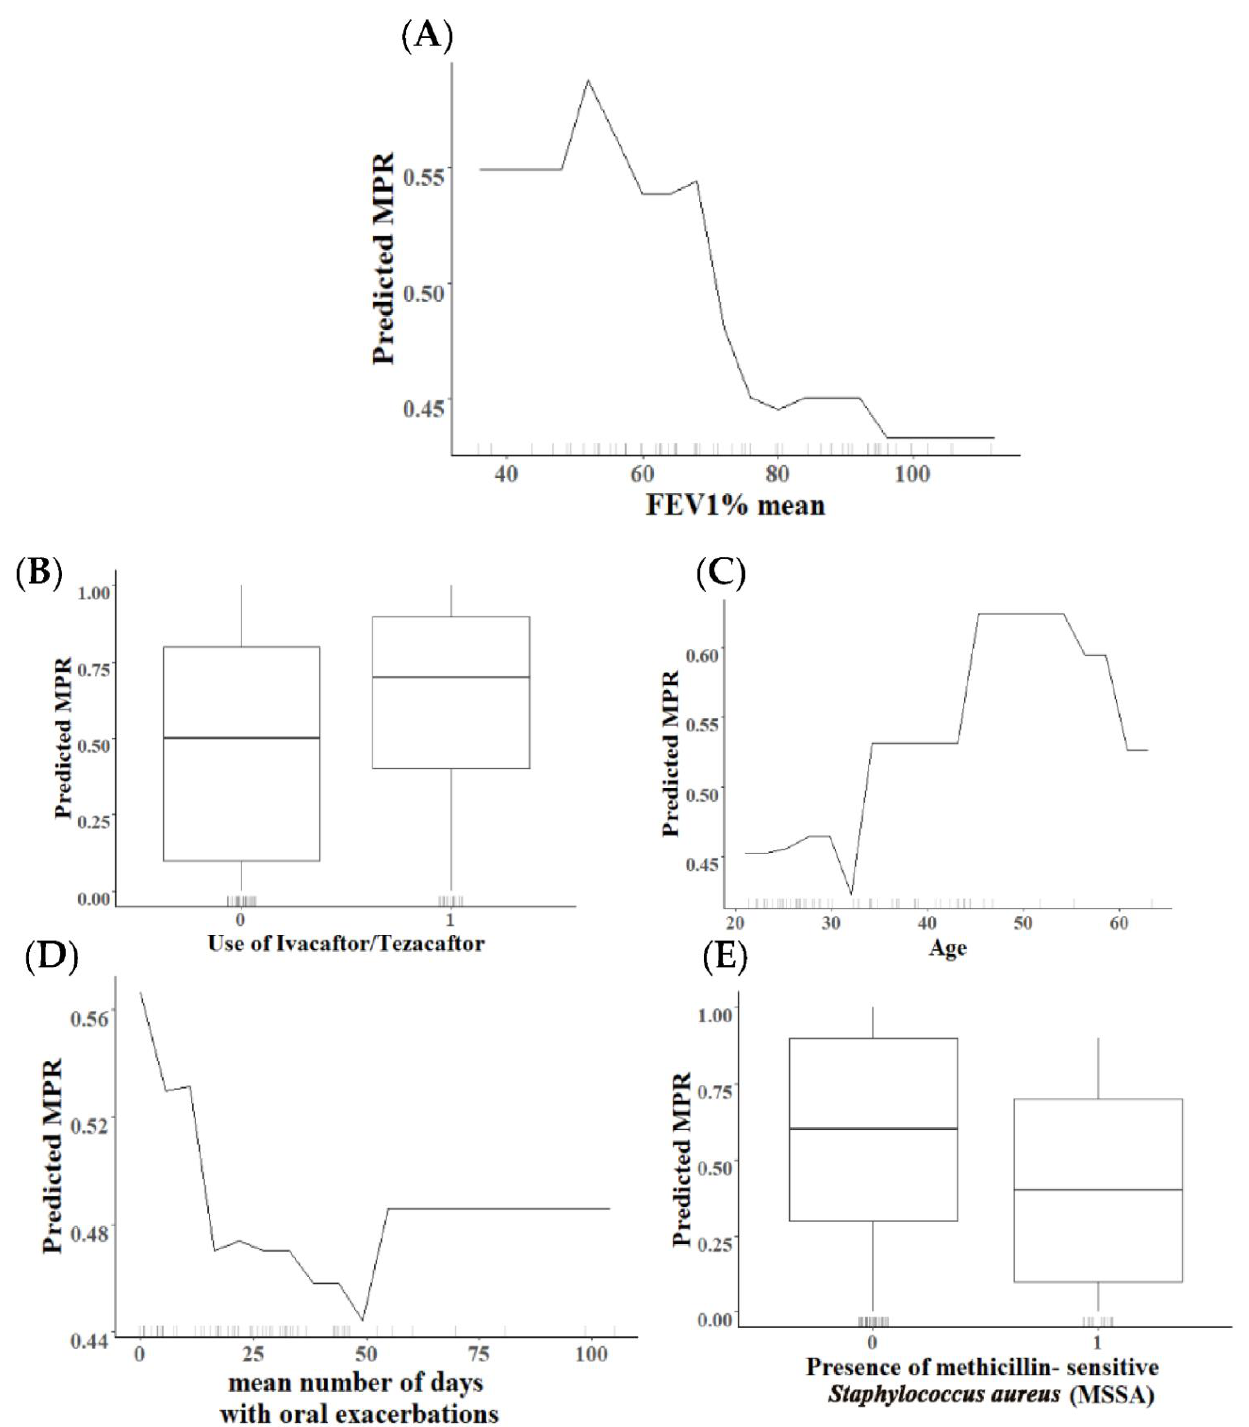
Figure 7. Partial dependence plots for the top 5 most important factors (Panel ( A ): FEV1% mean, panel ( B ): use of Ivacaftor/Tezacaftor, panel ( C ): Age, panel ( D ): mean number of days with oral exacerbations, panel E: and presence of methicillin-sensitive Staphylococcus aureus ) for high compliance.